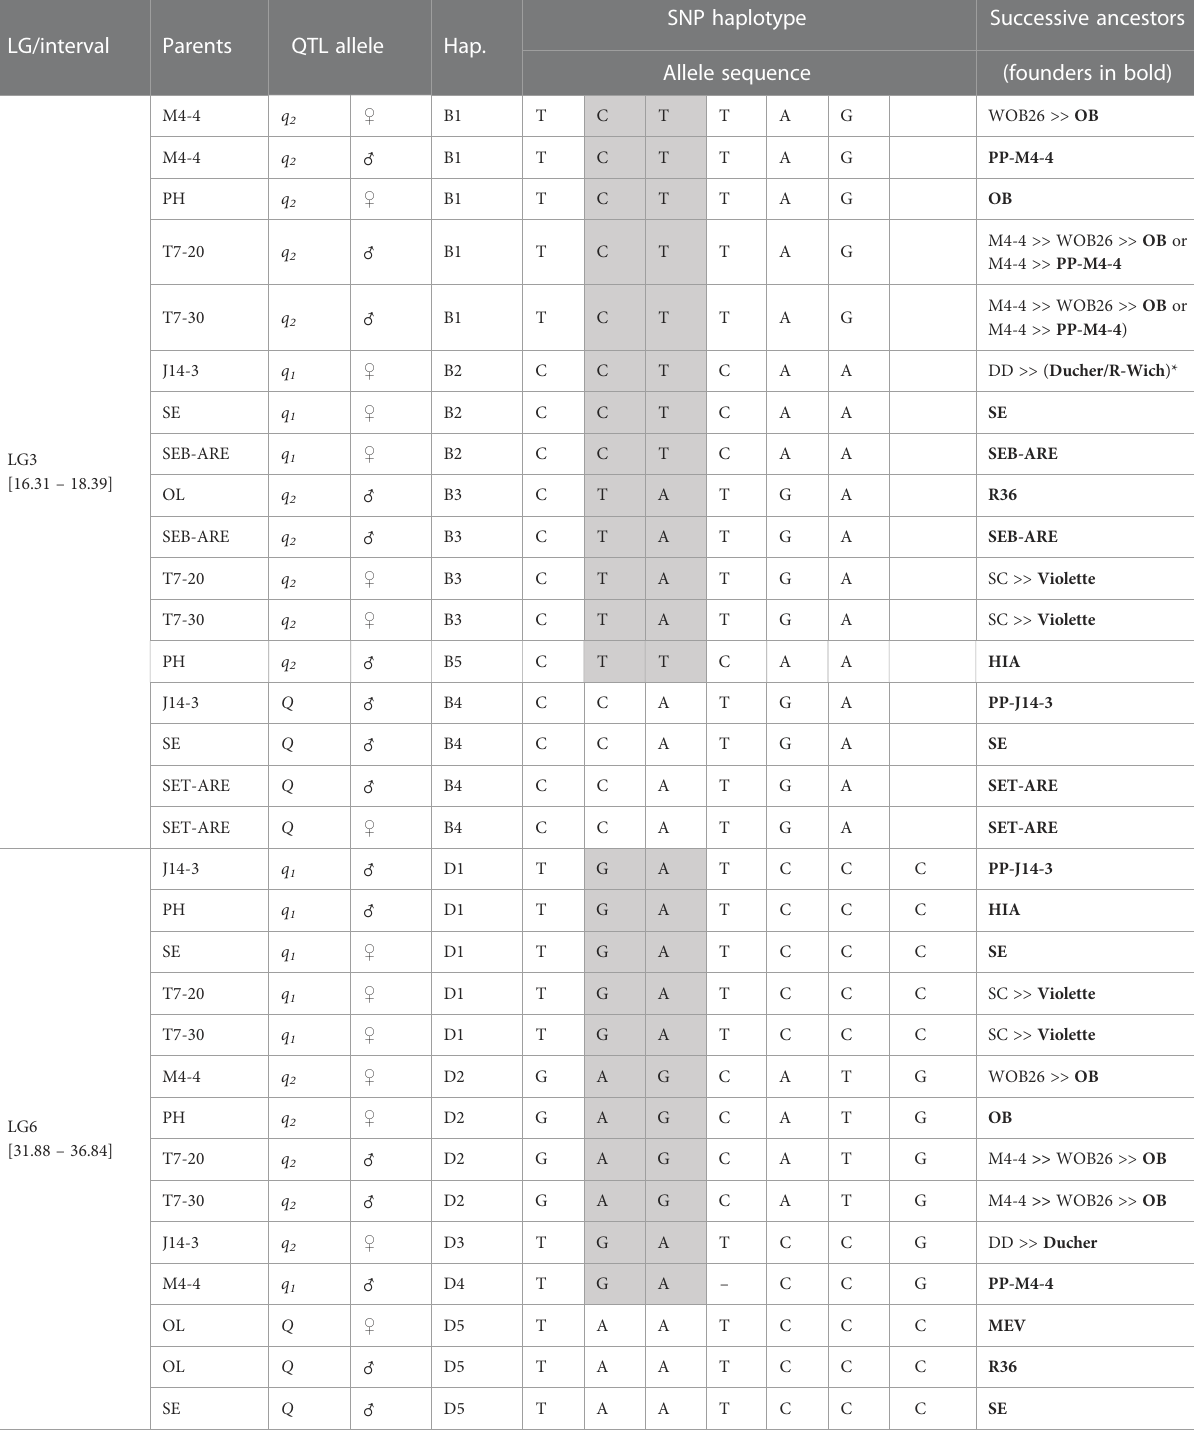
TABLE 4 QTL genotypes of q CLS.TX2WSE-LG3.1 and q CLS.TX2WSE-LG6.2 for studied breeding parents of the TX2WSE population, with SNP haplotype names, the haplotype ’ s SNP sequences, and original sources. LG/interval Parents QTL allele Hap.